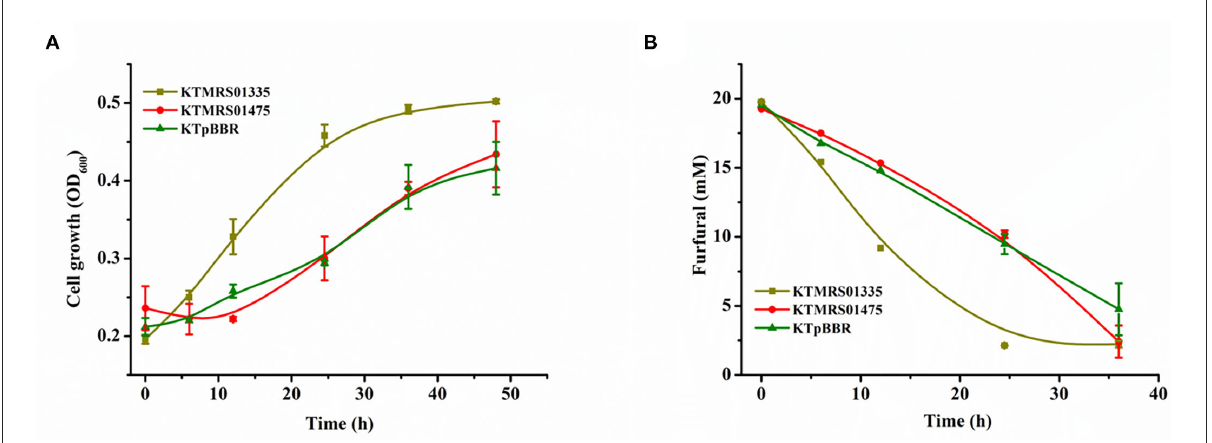
FIGURE5 Effects of strains overexpressing Indel genes on furfural tolerance. The cell growth curve (A) and furfural conversion (B) . All data are the mean value ± standard deviation of independent two